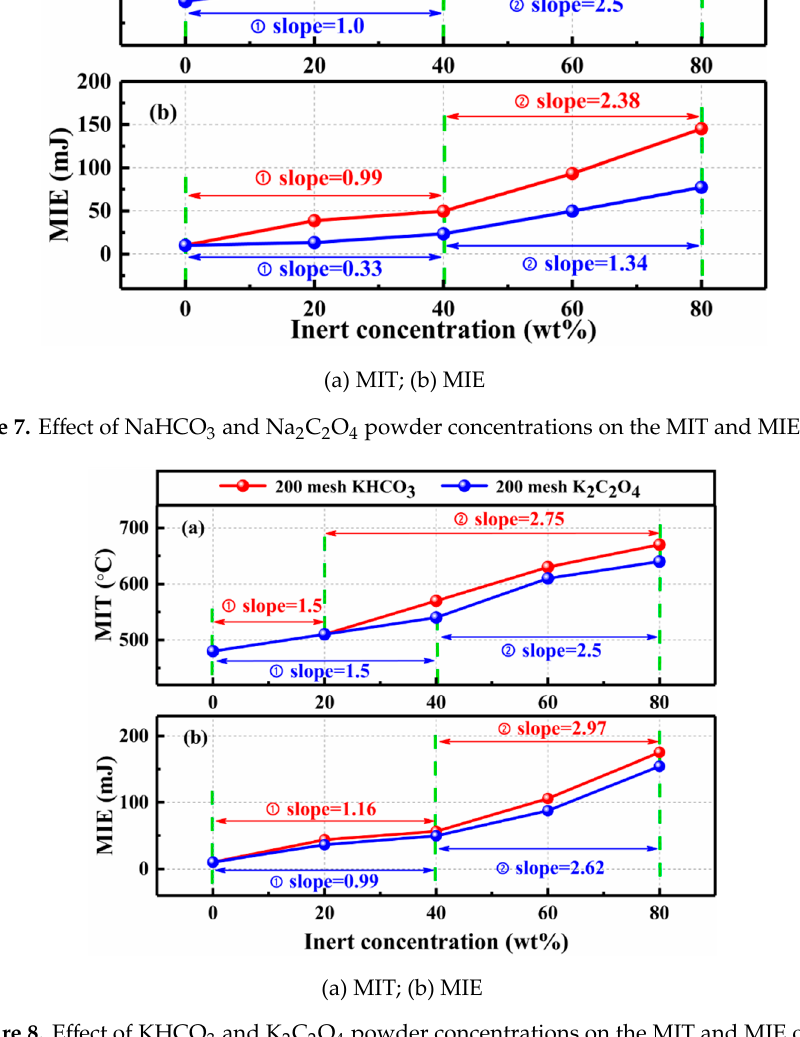
Figure 8. Effect of KHCO 3 and K 2 C 2 O 4 powder concentrations on the MIT and MIE of